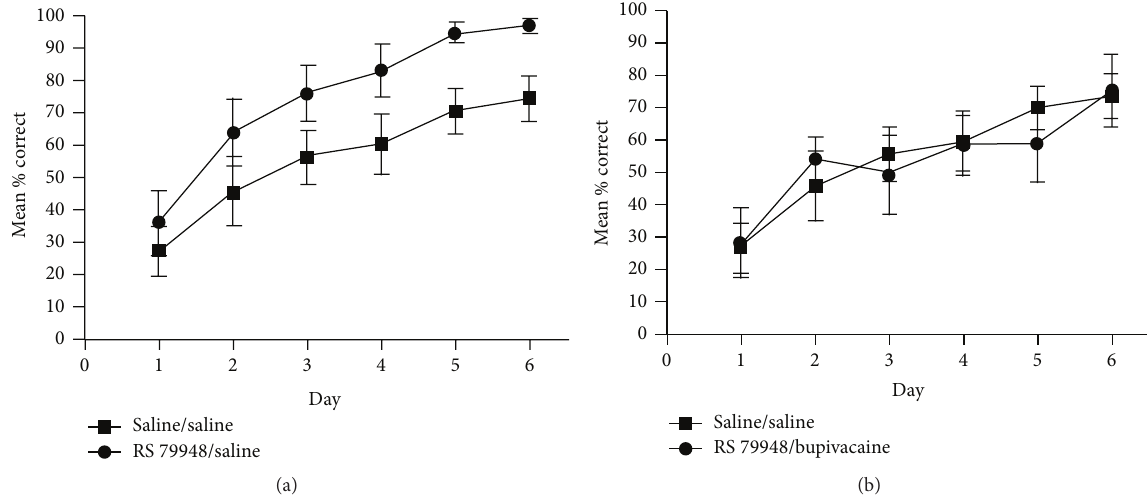
Figure 9: (a) Posttraining peripheral injections of RS 7948 enhance habit memory, but (b) BLA inactivation with bupivacaine blocks this enhancement